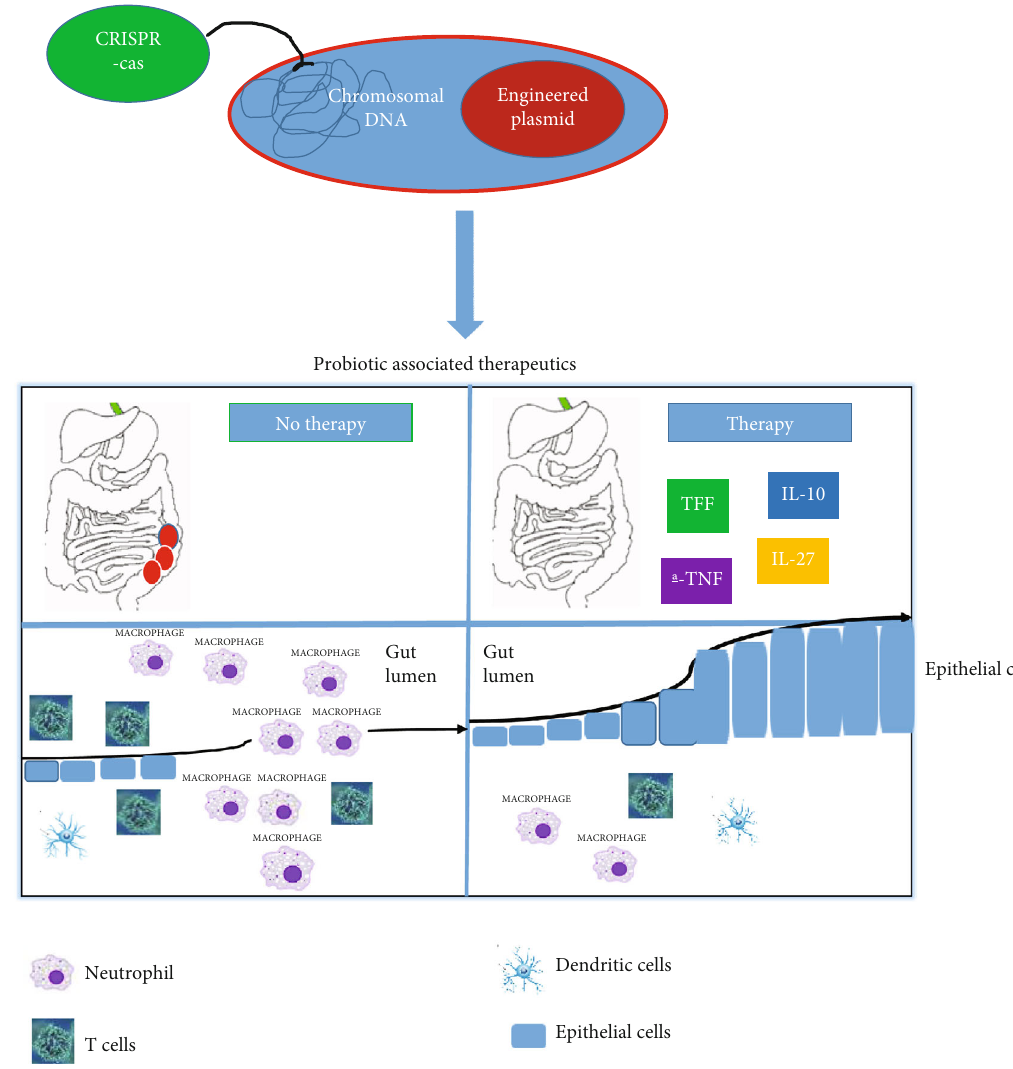
Figure 1: A model of cytokine-driven/targeted probiotic engineering. The promotor-driven expression of anti-in fl ammatory cytokines or antimicrobial peptides by the engineered probiotics may facilitate epithelial wound repair and the di ff erentiation/reformation of mucosal barrier through inhibiting the in fi ltration of in fl ammation causing immune cells, thereby decreasing both intestinal and systemic in fl